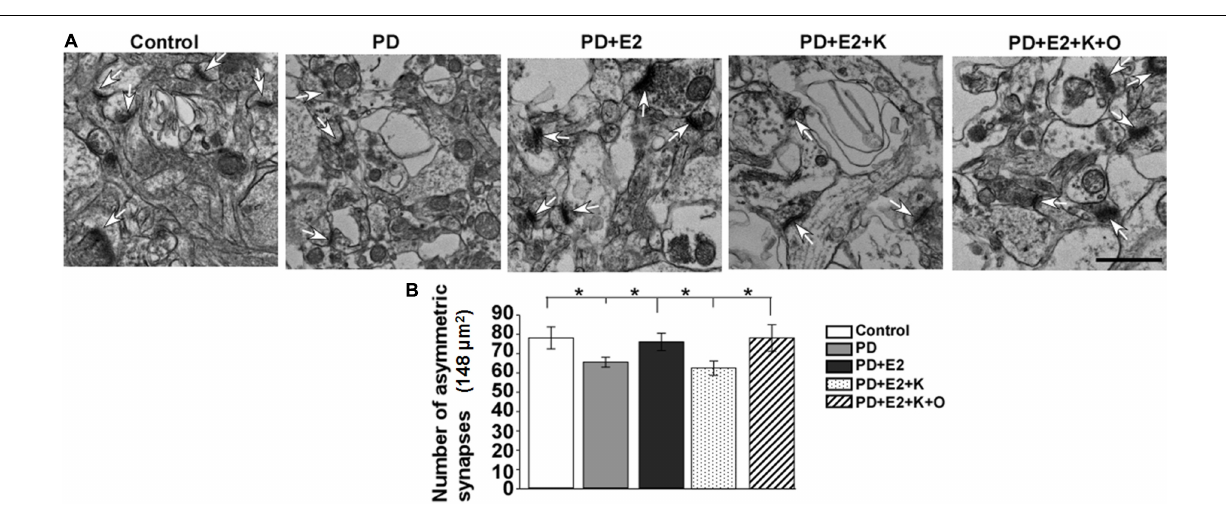
Figure 10 ) group than that in the PD + E 2 + anti-BDNF